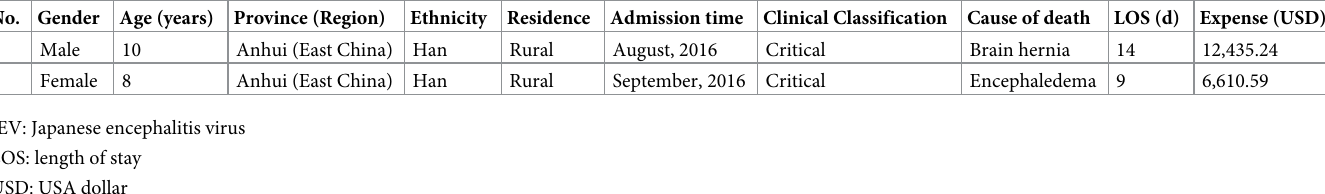
Table 5. The general sociodemographic characteristics and disease burden of two deaths from JEV infection during pediatric hospitalizations from December 2015 to December